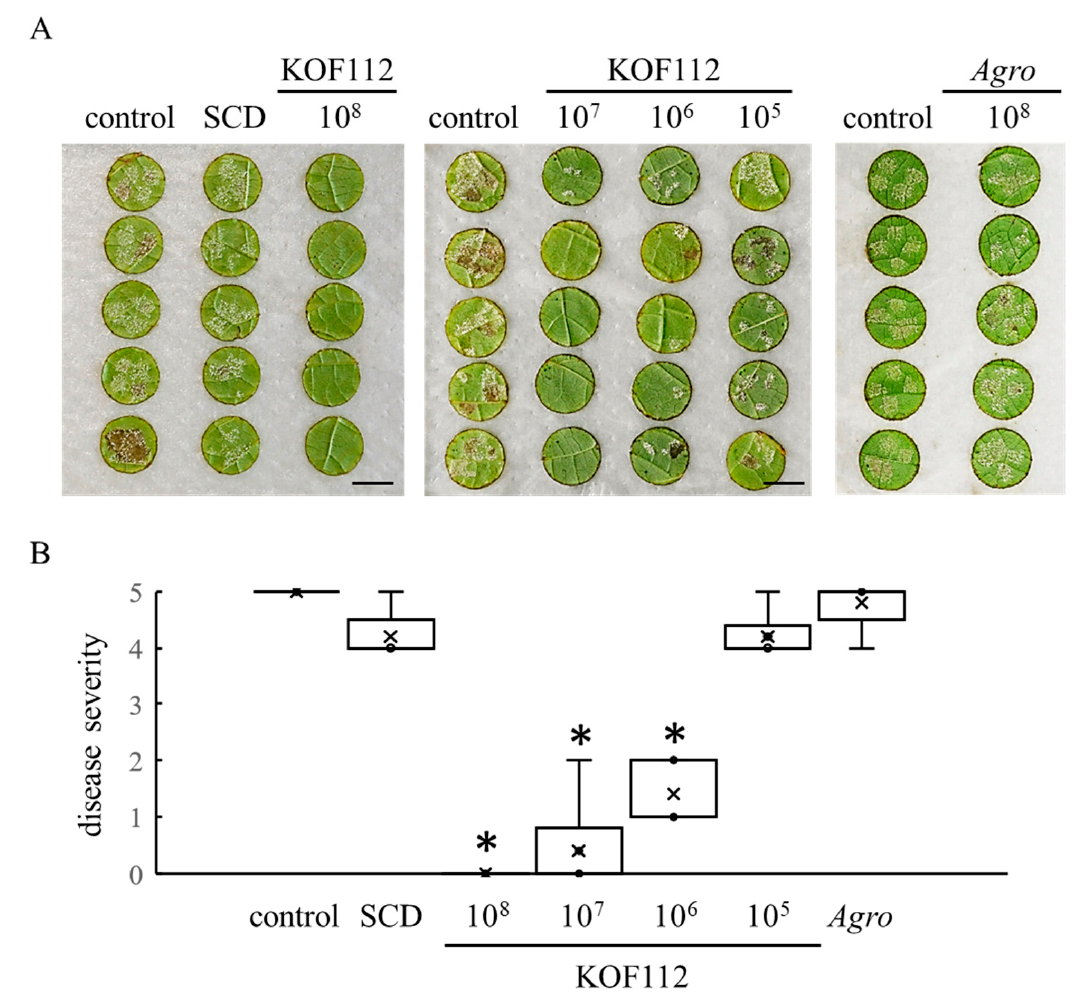
Figure 5. Suppression of grape downy mildew by KOF112. ( A ) Representative symptoms of grape downy mildew on leaf disks treated with KOF112 (1 × 10 8 , 1 × 10 7 , 1 × 10 6 or 1 × 10 5 cfu/mL) or Agrobacterium sp. isolate CHB3 (1 × 10 8 cfu/mL). Bar, 1 cm. ( B ) Disease severity was evaluated as described in Materials and Methods. Crosses ( × ) indicate means of two independent experiments with five leaf disks. * p < 0.05 compared with control and SCD. Control, untreated. SCD, treated with 10% SCD. Agro , treated with Agrobacterium sp. isolate CHB3 used as control isolate with no antifungal activity.